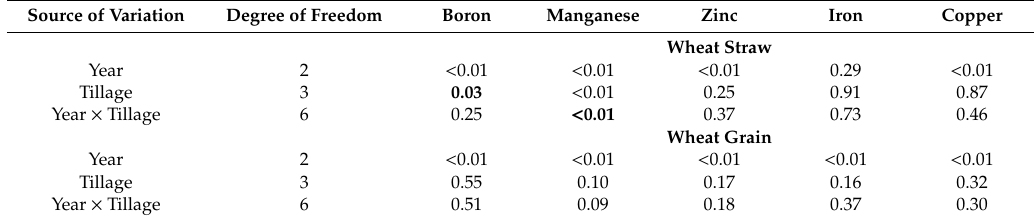
Table 4. ANOVA table of the main and interaction e ff ects of year and treatment on the accumulation of B, Mn, Zn, Fe, and Cu in the grain and straw of wheat–pea rotation long-term experiment (WP-LTE) at Pendleton.